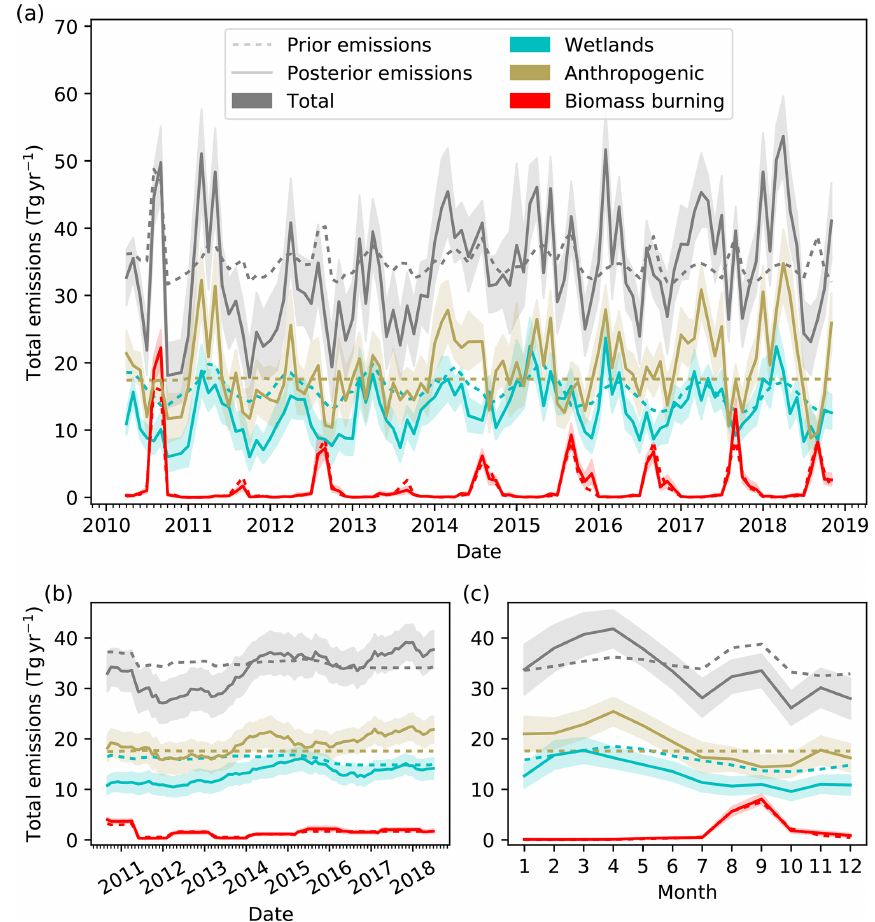
Figure 4. Brazil’s CH 4 emissions derived from GOSAT and RPB measurements between 2010 and 2018. Total emissions (grey) are split into the three major sectors: wetlands (cyan), anthropogenic (yellow) and biomass burning (red). Prior and posterior emissions are dashed and solid lines, respectively. Shading indicates the 95% confidence interval. (a) Monthly emissions, (b) monthly emissions smoothed with a 12-month rolling mean and (c) monthly means across the 2010 to 2018 period. Errors in mean values assume a 50% correlation between individual